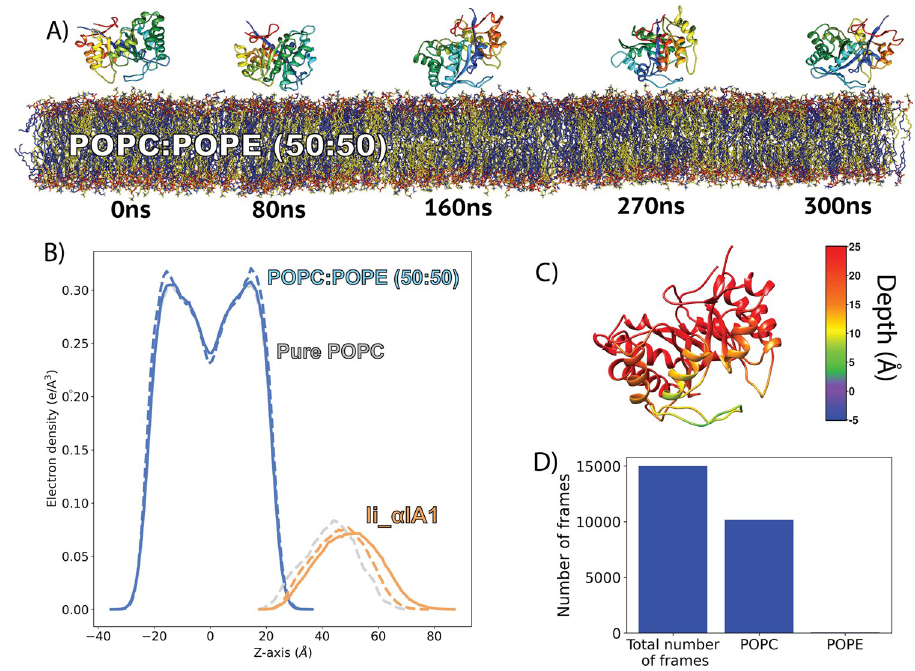
Fig 7. Binding of Li_ α IA1 to a POPC:POPE bilayer. A) Simulation snapshots for replica. 2. B) Electron density plot for Li_ α IA1 and the POPC:POPE (50:50) bilayer for two replicas (solid lines for R1 and dashed lines for R2, blue for the bilayer and orange for the protein). For the sake of comparison, the electron density plots for Li_ α IA1 and the pure POPC bilayer are represented in grey. C) Depth of anchorage. D) The number of frames where a POPC or POPE lipid is in the aromatic cage, compared to the total number of frames. A lipid is considered in the cage when the distance between the center of mass of the aromatic cage and the nitrogen atom of the lipid (POPC or POPC) is lower than or equal to 6 Å .